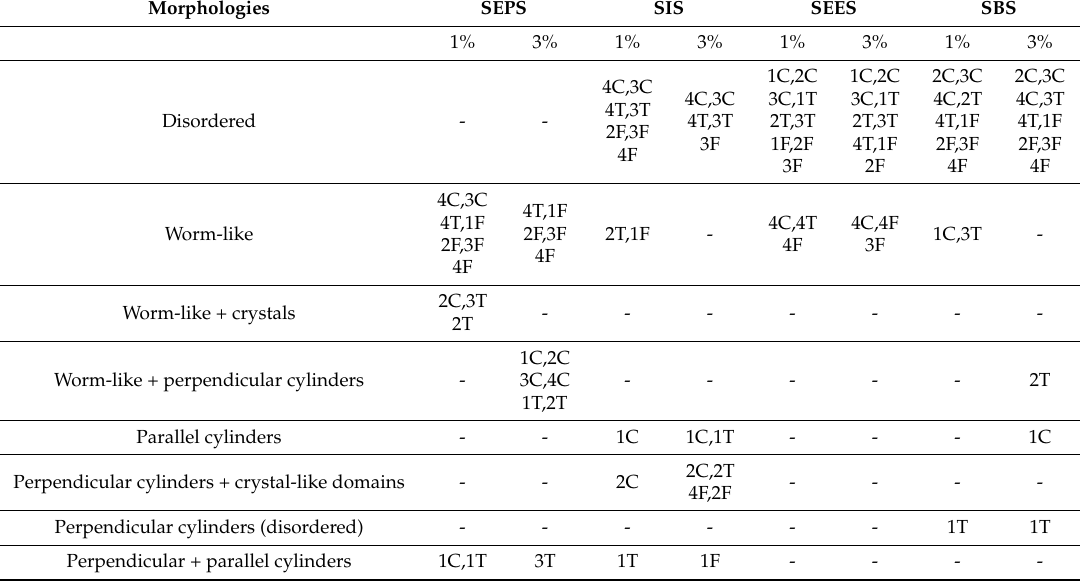
Table 3. Characteristic morphologies observed for all samples with different solvents (cyclohexane, toluene, and THF), annealing temperatures (room temperature (RT), and 60, 80 and 100 ◦ C),